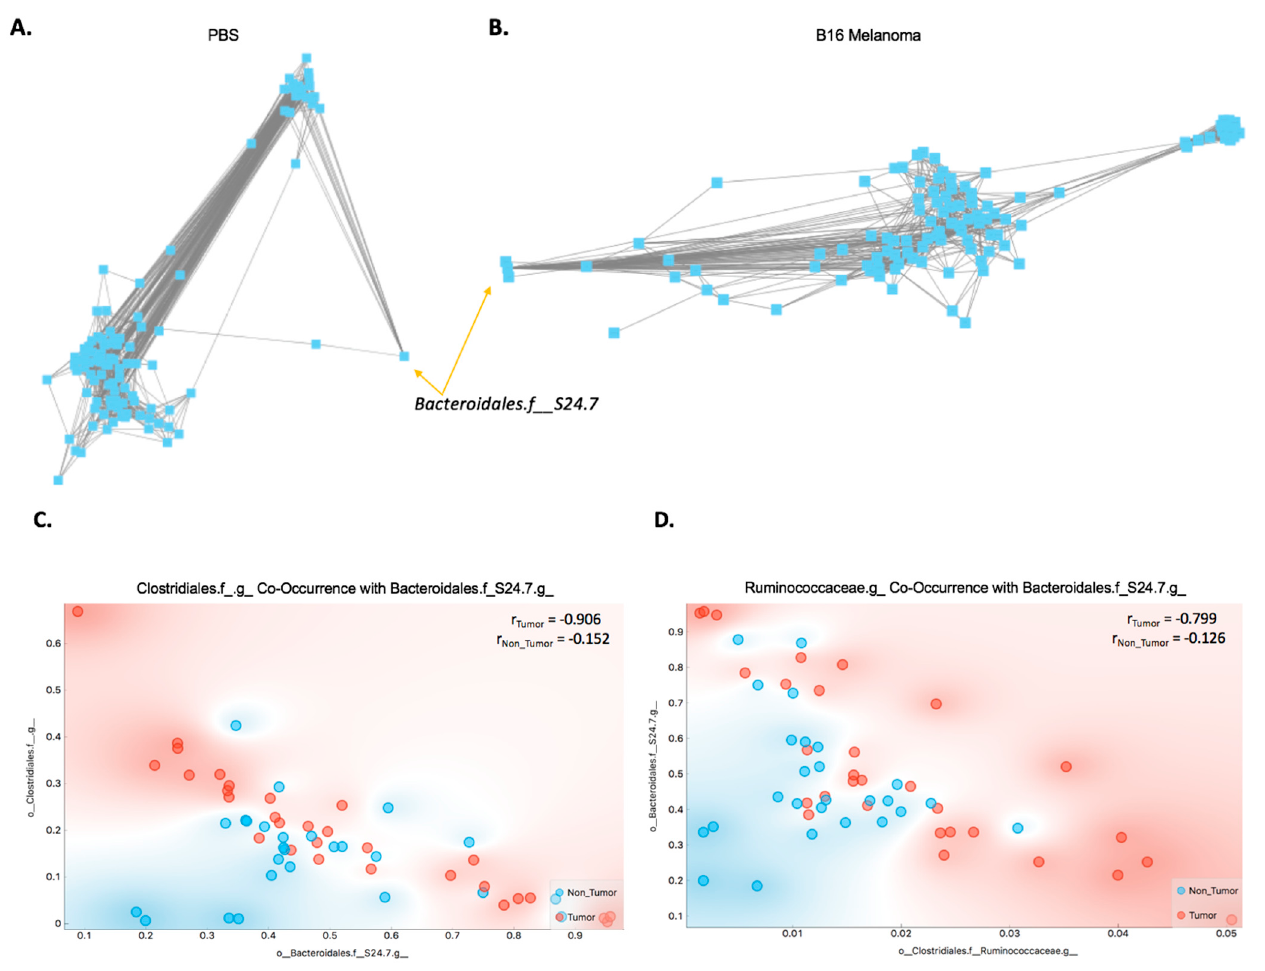
Figure 2. Co-occurrence changes between Bacteroidales.f__S24.7 , Clostridiales, and Ruminococcaceae occur with tumor presence. ( A , B ) Pearson correlation matrices were determined for microbiotas from tumor and nontumor mice and displayed using Cytoscape. From these visualizations, Bacteroi- dales.f__S24.7 co-occurrences greatly changed with tumor presence. ( C , D ) Using the R programming language, it was found that the most dramatic shifts of Bacteroidales.f__S24.7 were in conjunction with Clostridiales and Ruminococcaceae . ( E ) When comparing each taxon individually between tumor and nontumor, only Ruminococcaceae was significantly different. 2.3. Differences in Principal Components between Tumor and Nontumor Considering our results for both individual microbial taxa and co-occurrence shifts, we wanted to assess the relevance of each taxon in the context of predictive modeling. Thus, we calculated the information gains and ReliefF weights for each taxon (Figure 3A,B). In the scoring for information gains, Ruminococcaceae , Peptococcaceae.g_rc4.4 , and Christensenellaceae consistently scored higher than the majority of taxa (Figure 3A). For the ReliefF algorithm, Bacteroidales.f__S24.7 had a fairly high weight, along with Peptococca- ceae.g_rc4.4 and Christensenellaceae (Figure 3A). Further, Christensenellaceae was found to be significantly different between tumor and nontumor (Wilcoxon p < 0.05, Figure 3A,B). Considering that Bacteroidales.f__S24.7 shifted its co-occurrences and its ReliefF weight in- dicated variable importance, we performed a principal component analysis (PCA) using this taxon (Figure 3C,D). Two PCAs were performed, one with Clostridiales and the other with Ruminococcaceae (Figure 3C,D) . After performing the PCAs, we compared the result-